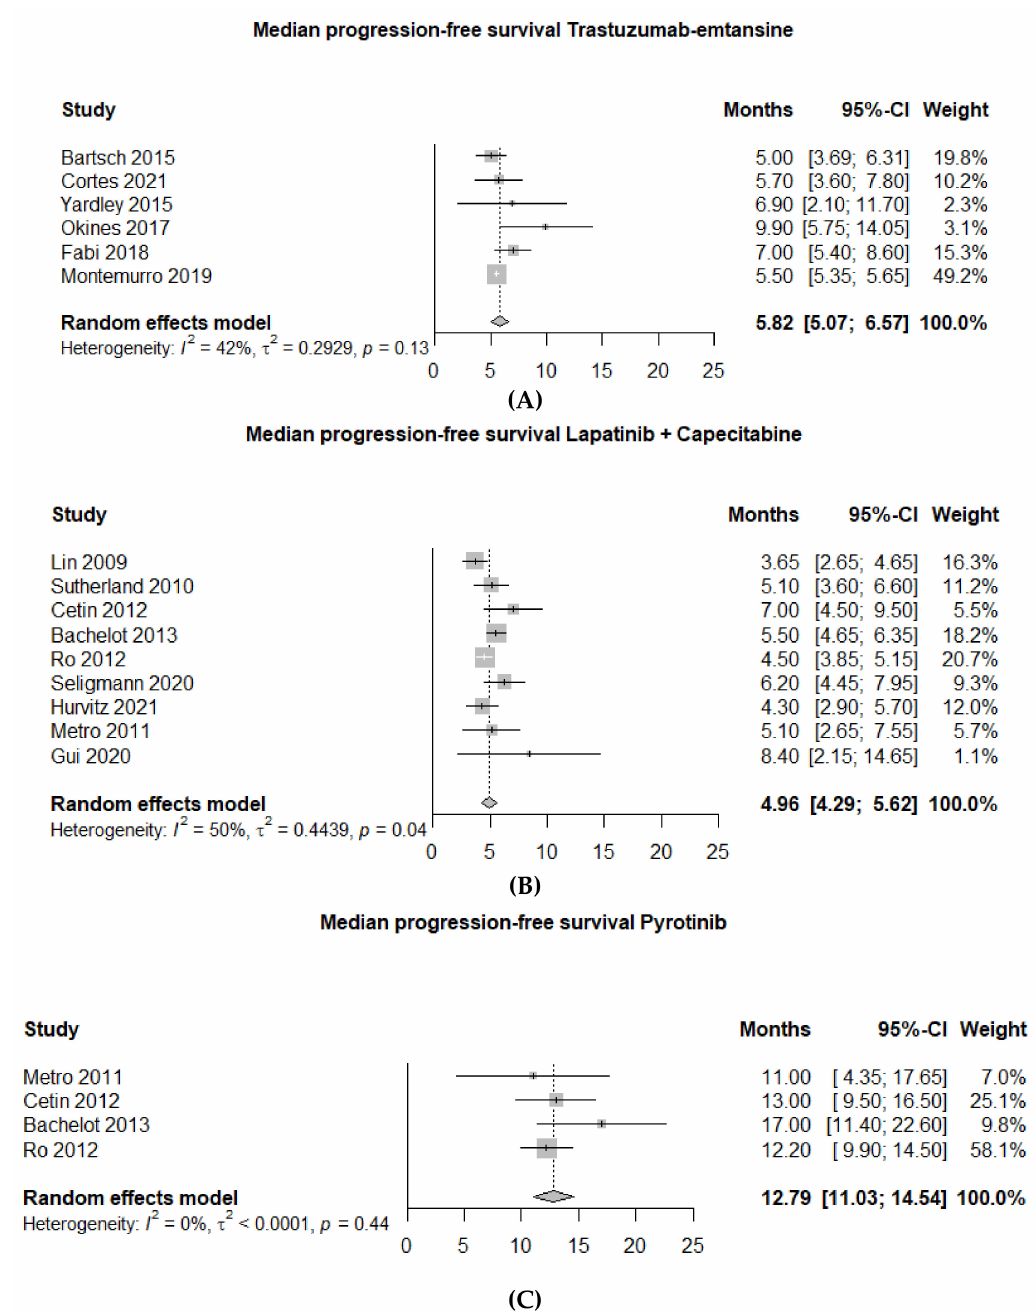
Figure 4. Pooled mPFS (months) meta-analysis; ( A ) Trastuzumab-emtansine (T-DM1); ( B ) Lapatinib + capecitabine (LC); ( C ) Pyrotinib. T-DXd was studied in 3 trials and 96 patients (Table 1); 2 single arm phase 2